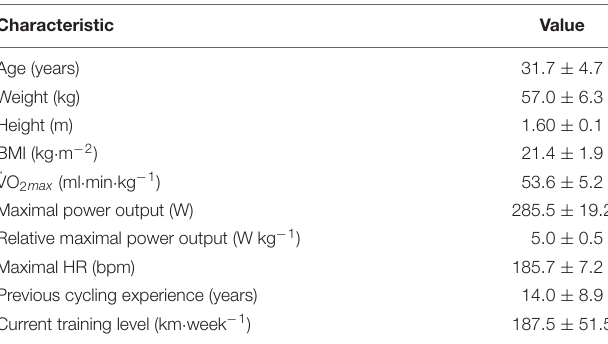
TABLE 1 | Anthropometric and physical performance characteristics of the cyclists (mean ±